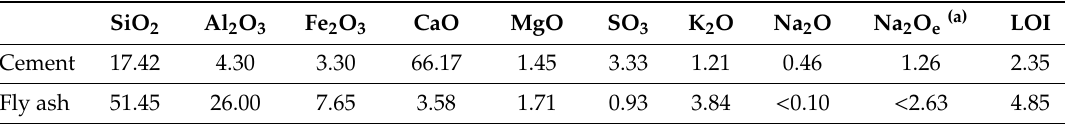
Table 2. Chemical composition of cement and fly ash, wt % (by X-ray fluorescence).